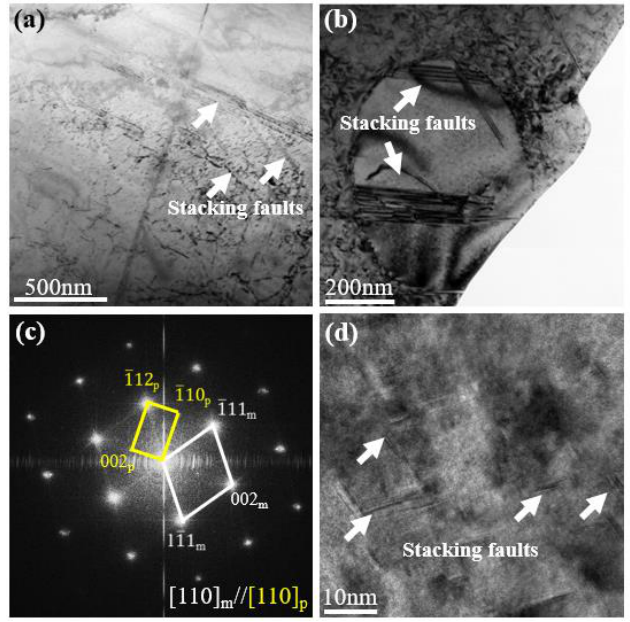
Figure 5. Deformation microstructures after the tensile test at 650 °C: ( a ) t he SFs in the γ matrix; ( b ) t he SF in the γ′ precipitates; ( c ) a SAED pattern corresponding to ( a ); ( d ) HRTEM image showing SFs.